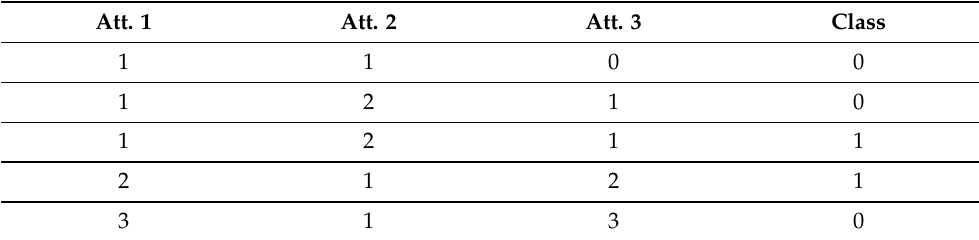
Table 1. Simple example of dataset distribution. Att. 1 Att. 2 Att. 3 Class 1 1 0 0 1 2 1